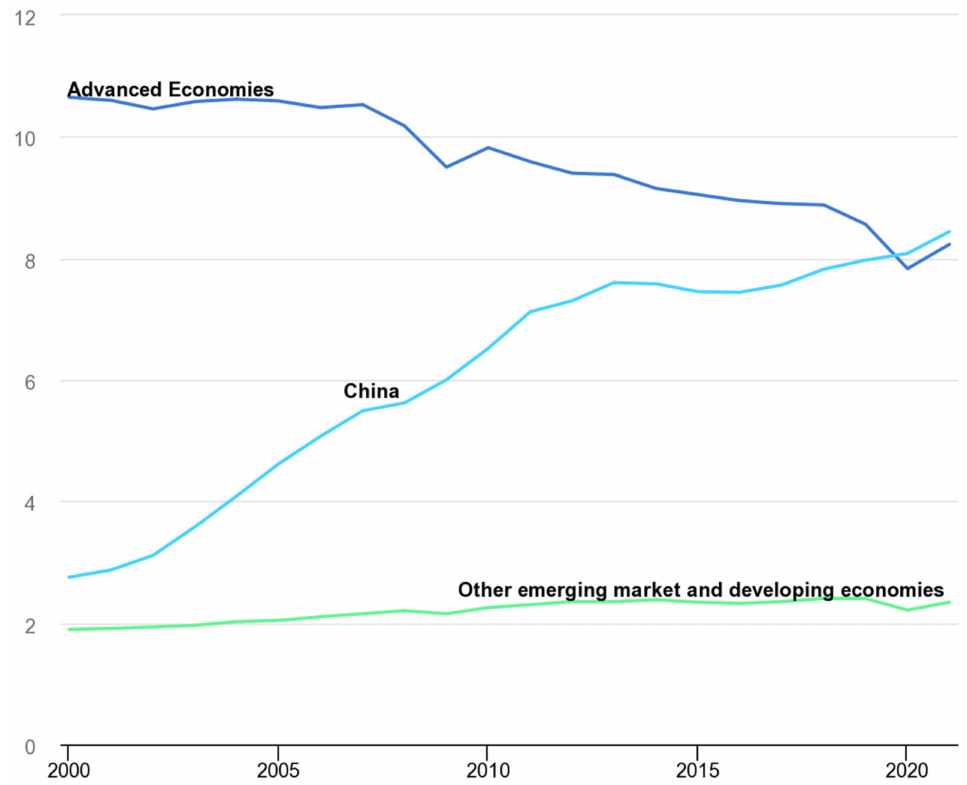
Figure A1. Graphical scheme for CO 2 emissions by region. Sources from IEA available at CO 2 emissions per capita by region, 2000-2021—Charts—Data &